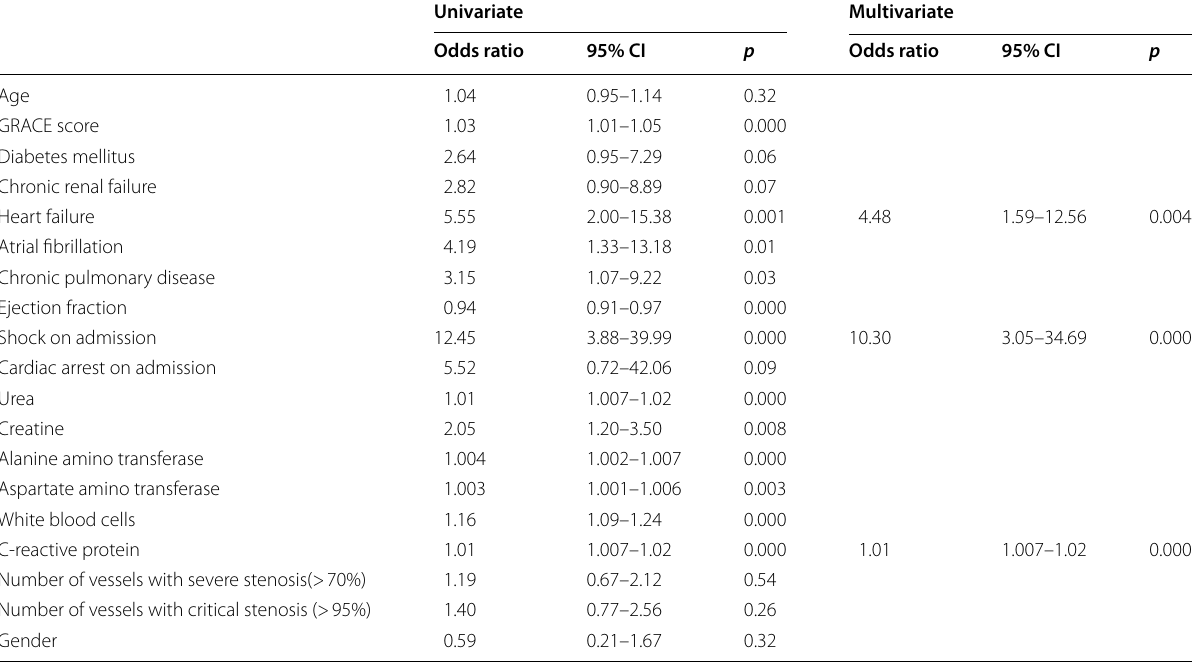
Table 4 Cardiac cause mortality univariate and multivariate regression analysis